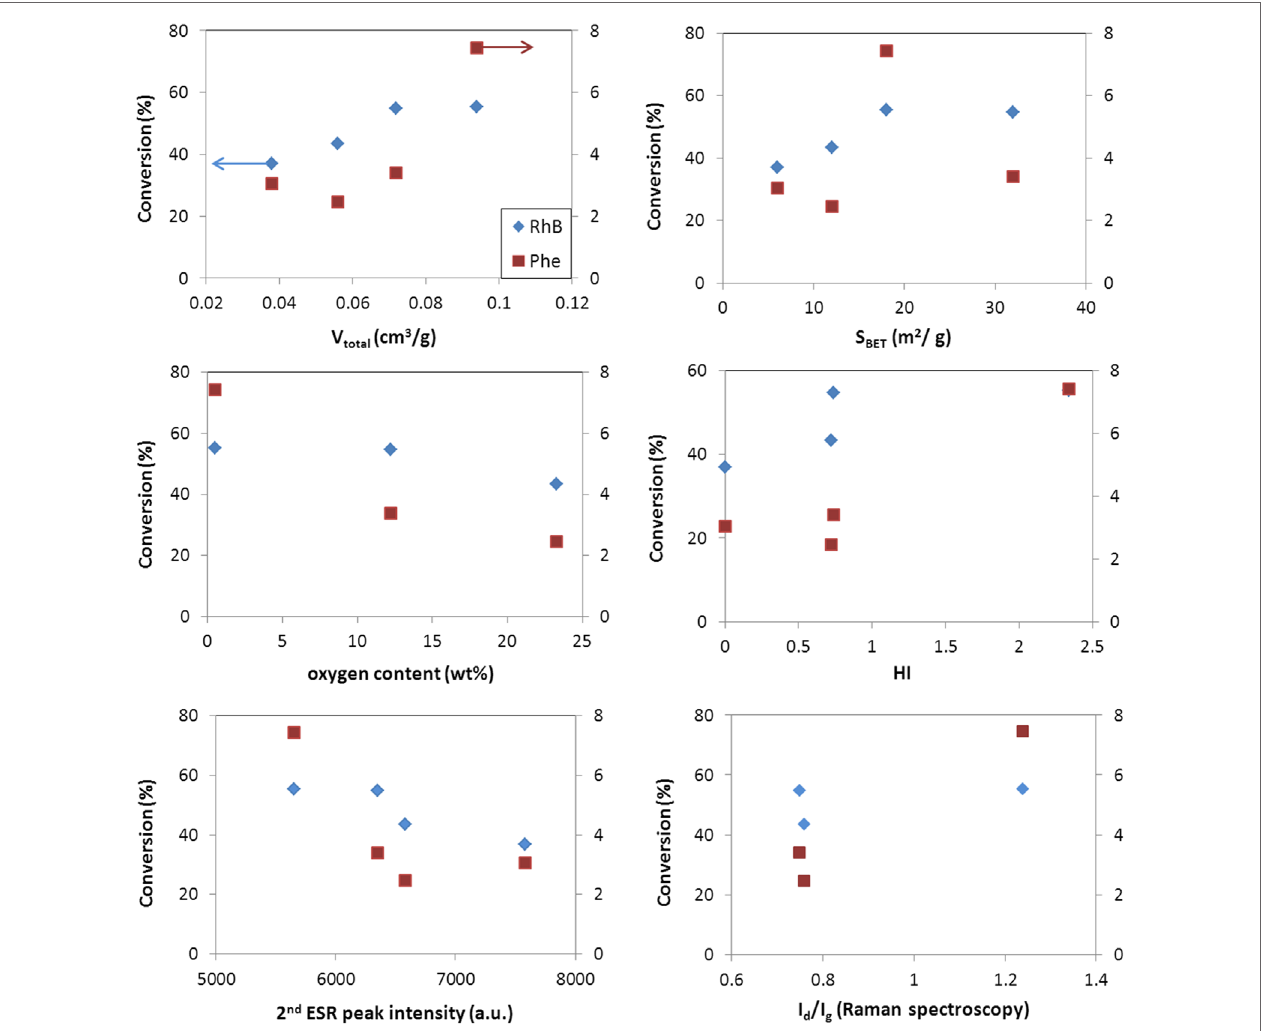
FigUre 6 | correlation of conversion values for phenol (right axis) and rhodamine (left axis) with selected characteristics of the WO 3 /carbon photocatalysts for a catalyst loading of 1 g/l